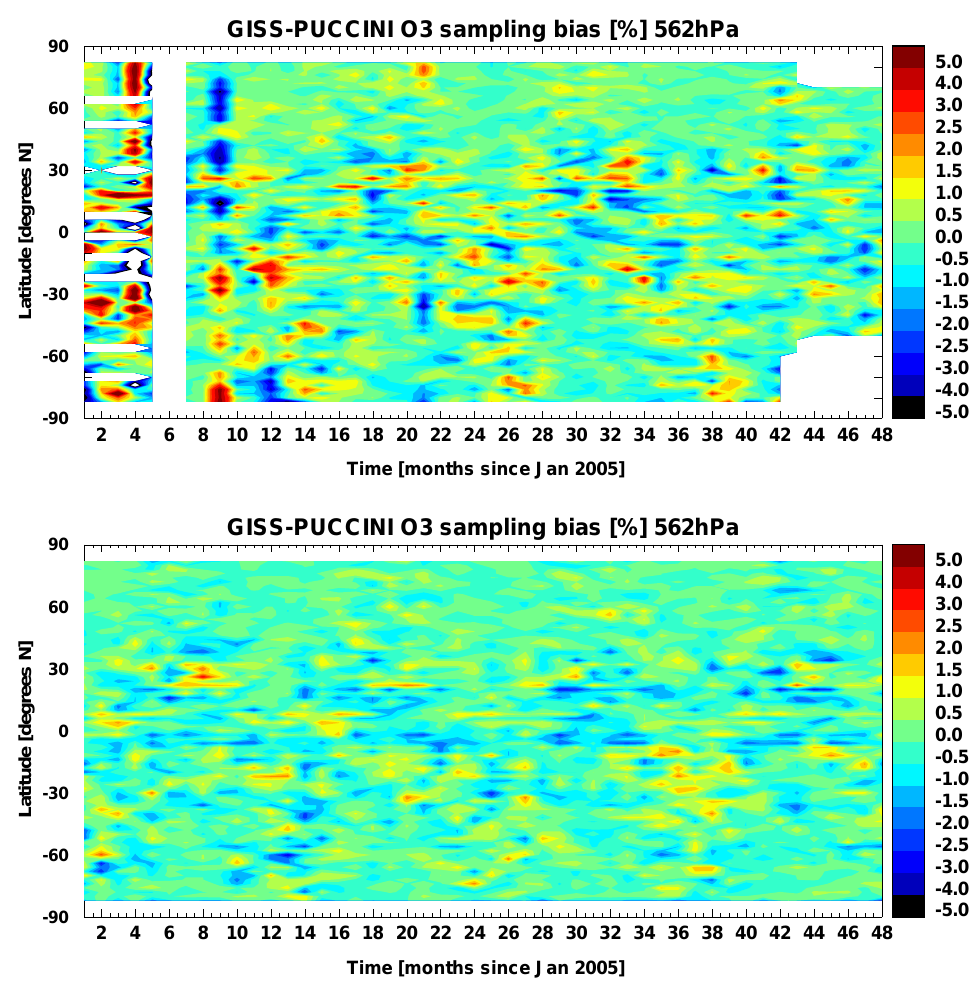
Fig. 7a. The latitudinal average time series of the percentage error in ozone calculated when the sampled points are screened with the quality flags (top) and not screened (bottom). The screened has the gap because TES performed no measurement in June